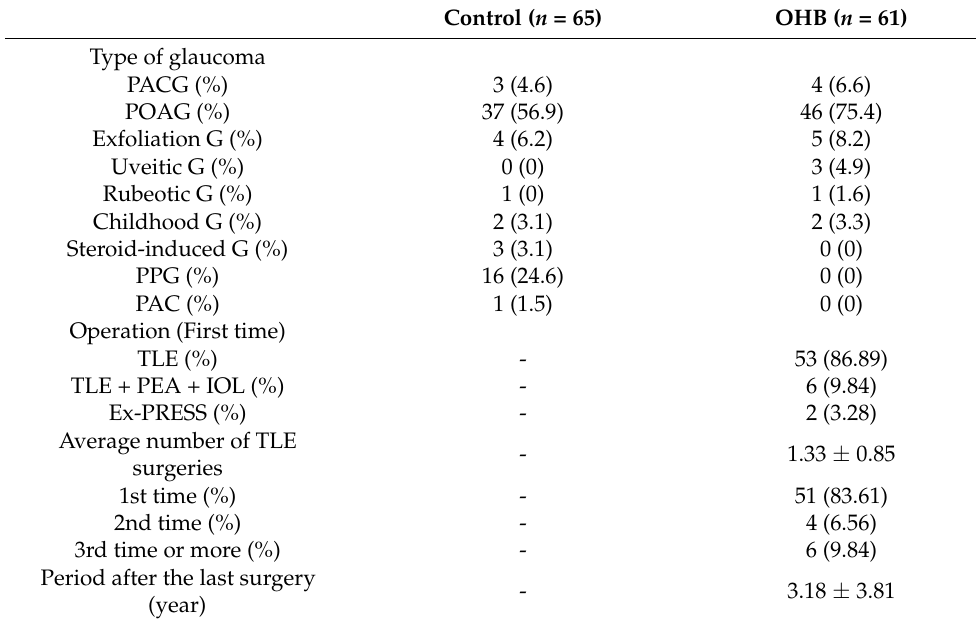
Table 2. Clinical characteristics of control and overhanging bleb